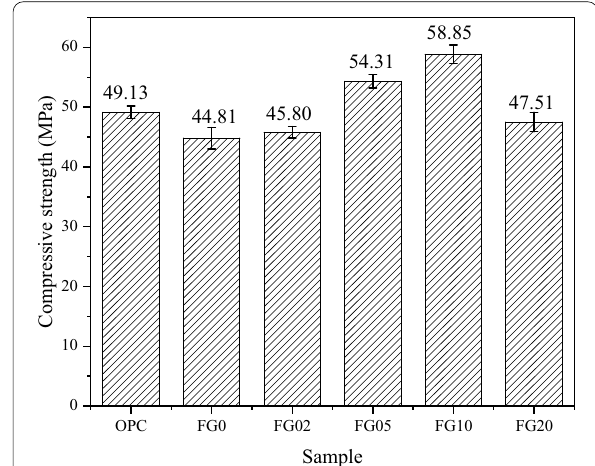
Fig. 9 Compressive strength of fly ash cement